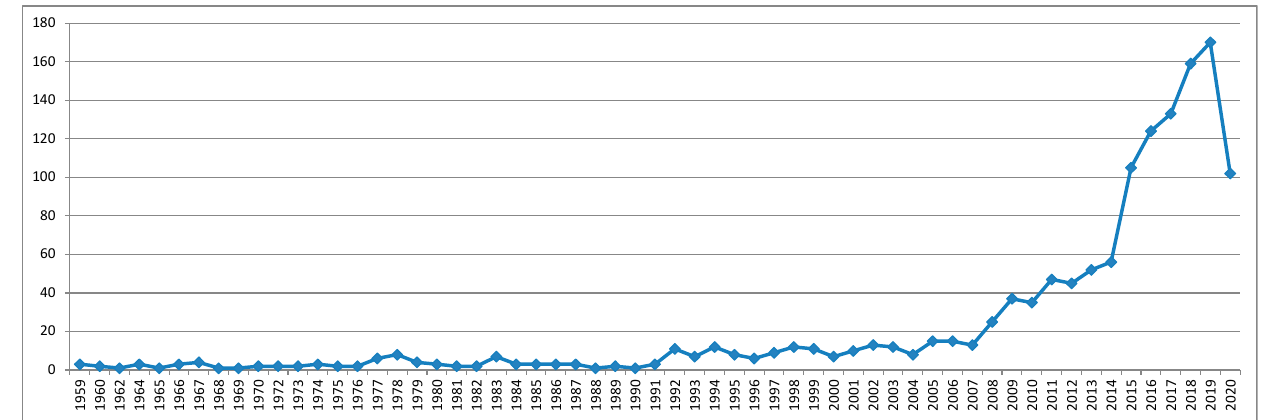
Figure 1. Distribution of records by year (WoS).